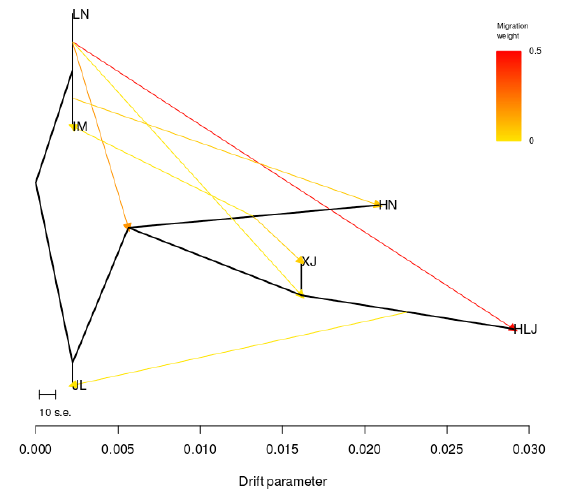
Figure 4. TreeMix analysis of the six geographic populations. The arrow corresponds to the direction of migration. Seven migration edges were allowed, as inferred using OptM. The migration edges are colored according to their weight ( ŵ ). The scale bar indicates ten times the average standard error of the values in the covariance matrix. LN: Liaoning population; IM: Inner Mongolia population; JL: Jilin population; XJ: Xinjiang population; HLJ: Heilongjiang population; HN: Henan population.